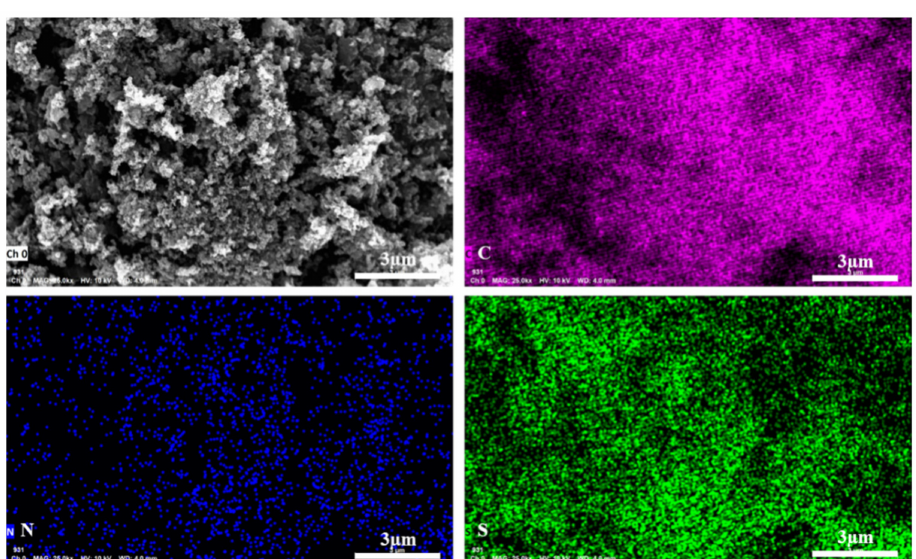
Figure 3. The elemental mapping of C, N and S of